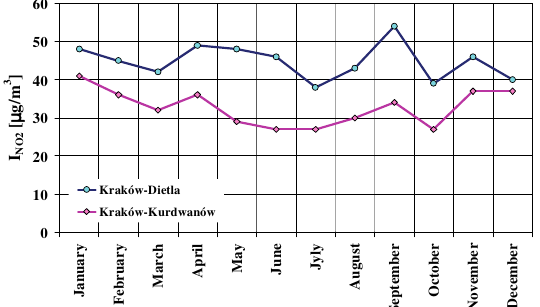
Fig. 6. The immission of nitrogen dioxide values obtained from Kraków– Dietla station and Kraków–Kurdwanów station in 2016